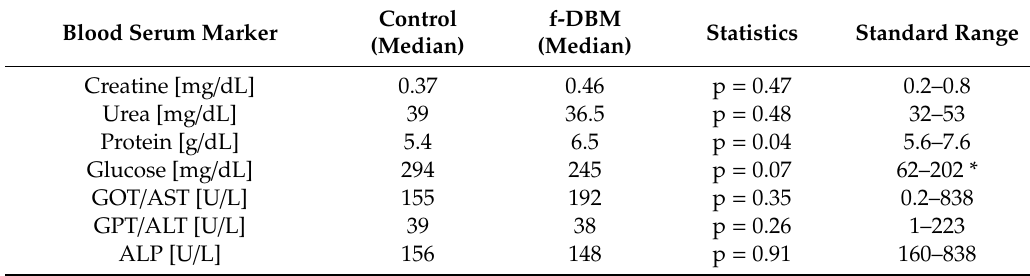
Table 3. Results of serum biochemistry of both groups: Significantly increased total protein concentrations in f-DBM animals. Standard ranges by Delwatta et al. [34]. * Sober blood sugar range.